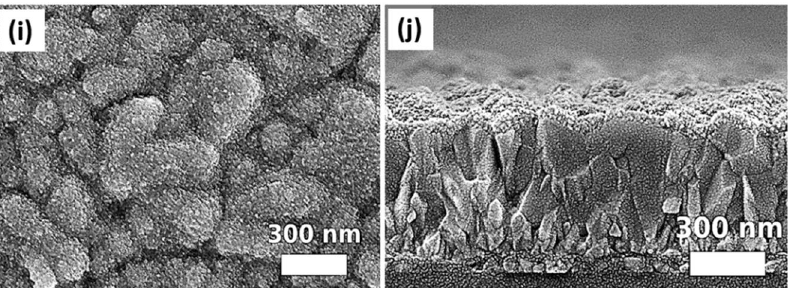
Figure 4. SEM top and cross-sectional images of samples grown in a ternary solvent system with different DI water-to-ethanol ratios: ( a , b ) 1:9, ( c , d ) 3:7, ( e , f ) 1:1, ( g , h ) 7:3, and ( i , j ) 9:1.